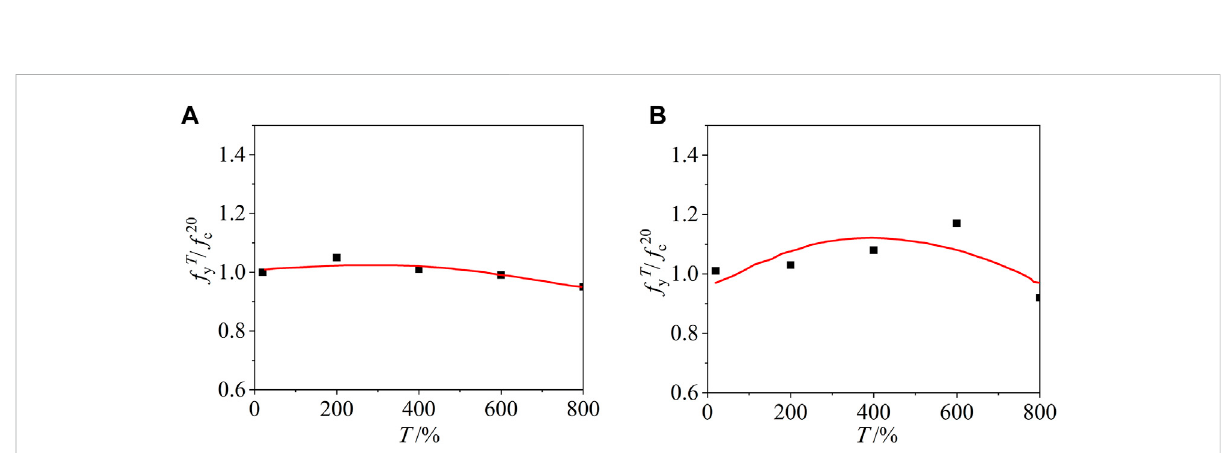
FIGURE 15 Effect of temperature on tensile strength of reinforcement. (A) longitudinal reinforcement; (B)